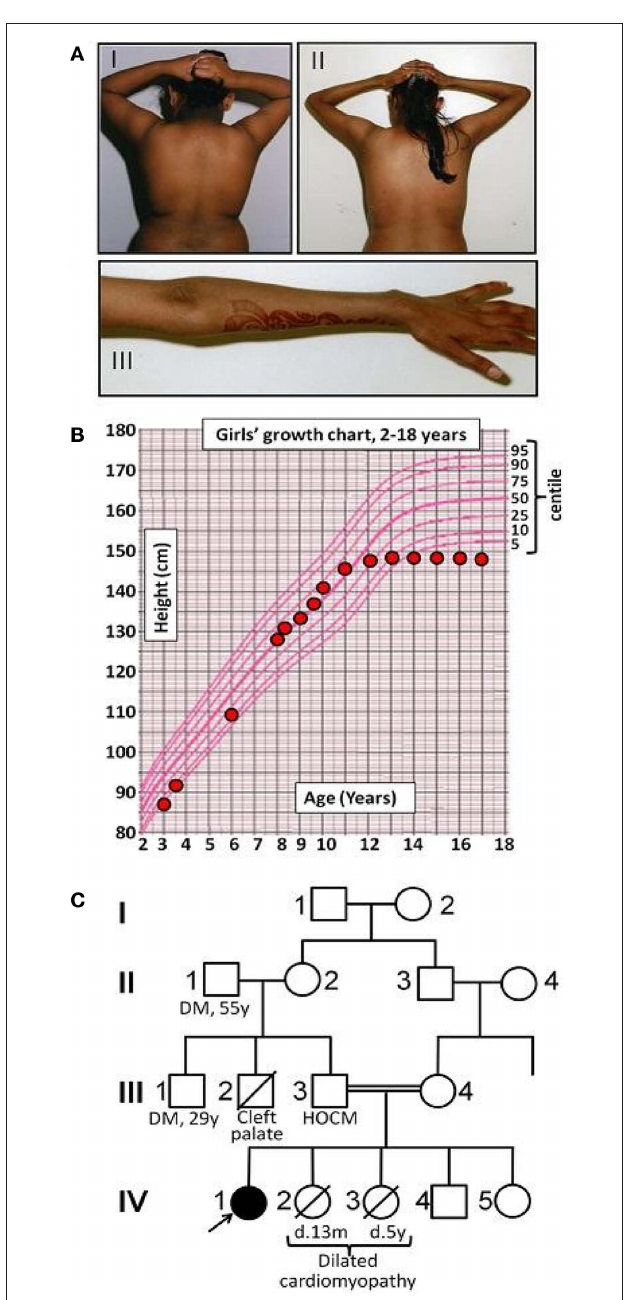
FiguRE 1 | Early clinical features of Werner’s syndrome in a 16-year-old female patient from a consanguineous family. (A) Clinical images of proband at (I) 7 years old and (II, III) 16 years old, showing truncal obesity and acanthosis nigricans in the neck and flexures at both ages, and marked loss of distal subcutaneous tissue from the arms by 16 years. (B) Growth chart showing failure of pubertal growth spurt, typical of Werner’s syndrome. (C) Pedigree diagram (HOCM, hypertrophic obstructive cardiomyopathy; DM, type II diabetes